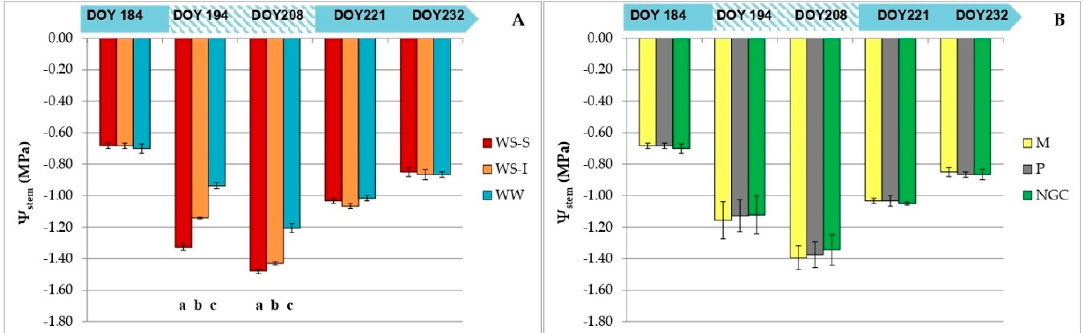
Figure 2. Midday stem water potentials ( Ψ stem , MPa) in adult leaves of Pinot noir, subjected to three irrigations protocols: ( A ) WS-S in red, WS-I in orange, and WW in blue. Leaf Water Potentials ( Ψ stem , MPa) in adult leaves in the three root systems: ( B ) Mgt 101-14 (M) in yellow, 1103 Paulsen (P) in dark grey, and not grafted vines (NGC) in green. The measurements were conducted before (DOY 184), during (DOYs 194 and 208, marked with dashed lines), and after (DOYs 221 and 232) the water stress trial. The bars indicate the standard error. Different letters indicate significant differences (LSD test, P < 0.05).